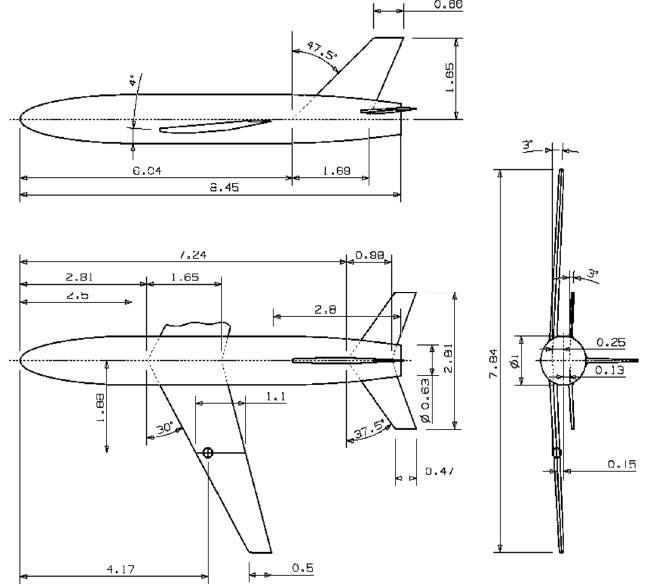
Figure 4. Theoretical geometry of ONERA-M standard model with dimensions given in terms of body diameter, based on [37].